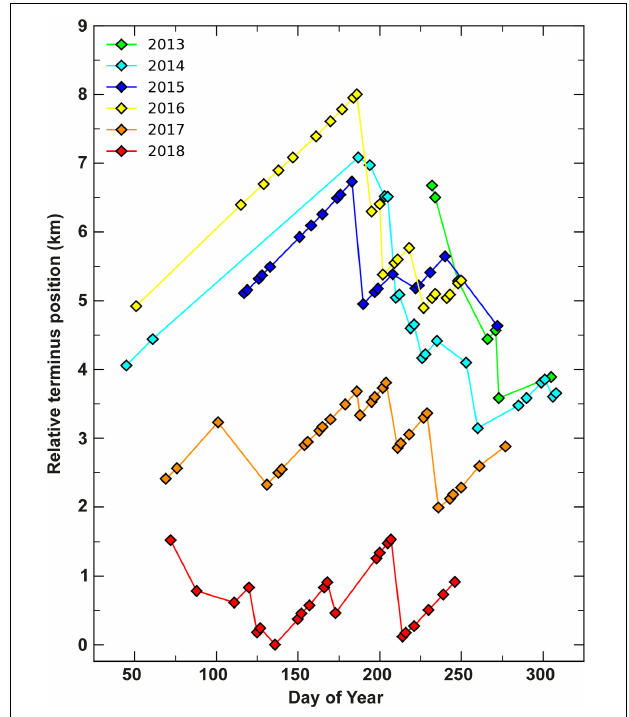
FIGURE 2 | Terminus position of Kangerlussuaq relative to the most retreated ice front (16 May 2018) plotted by day of the year from 2013 to 2018.